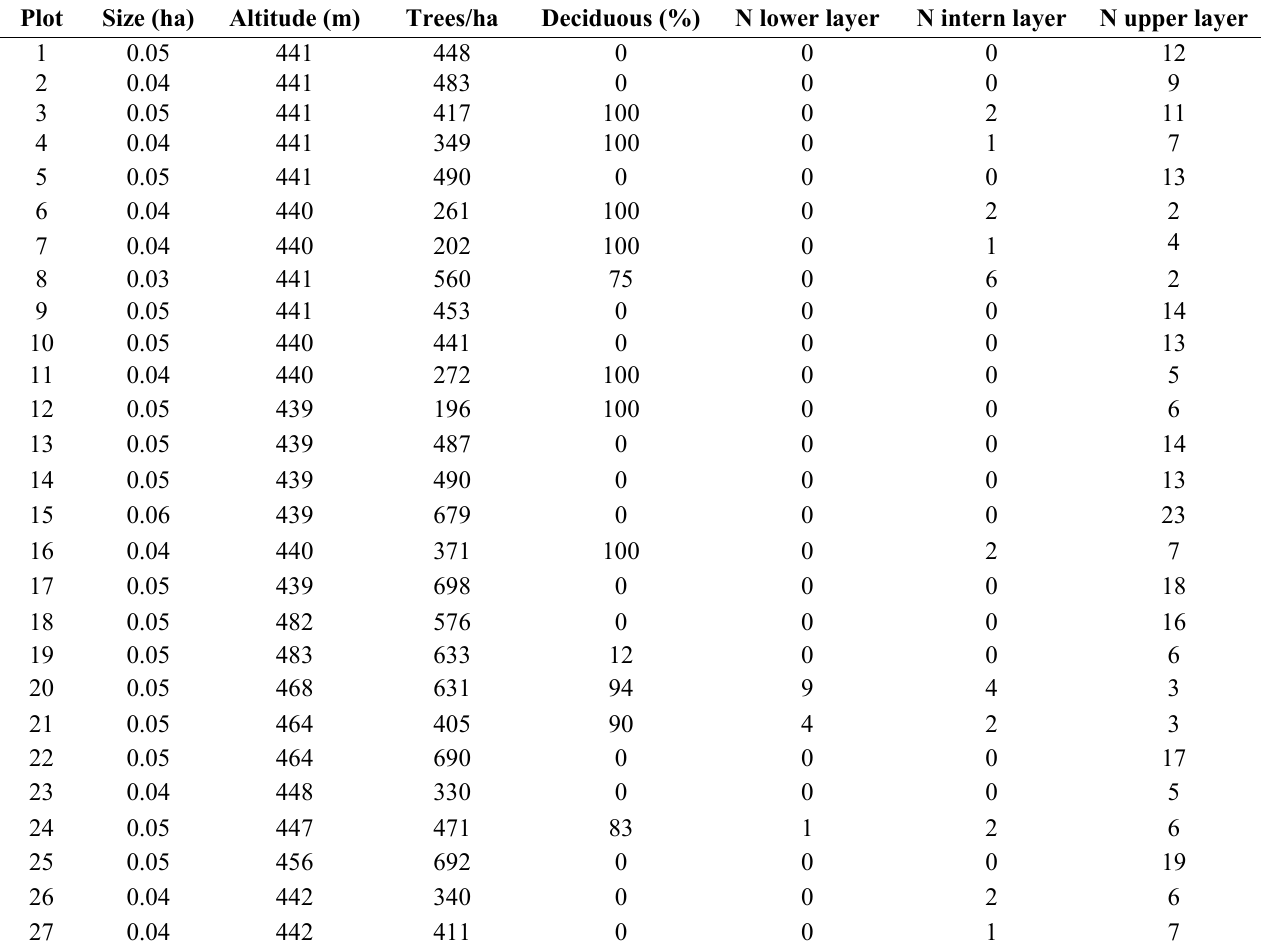
Table 3. Characteristics of sample plots in Test Site II; N stands for the number of